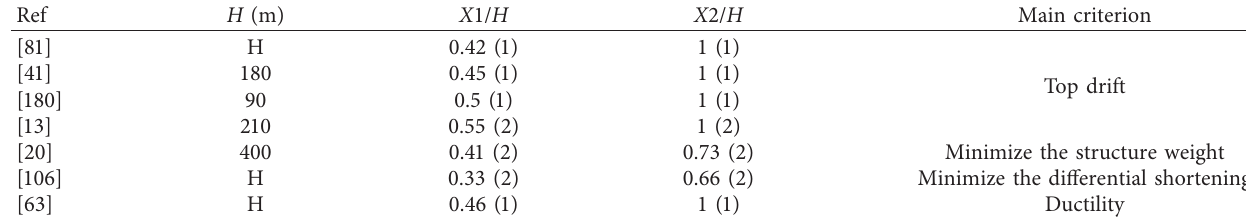
Table 4: RC core walls with two RC outriggers.